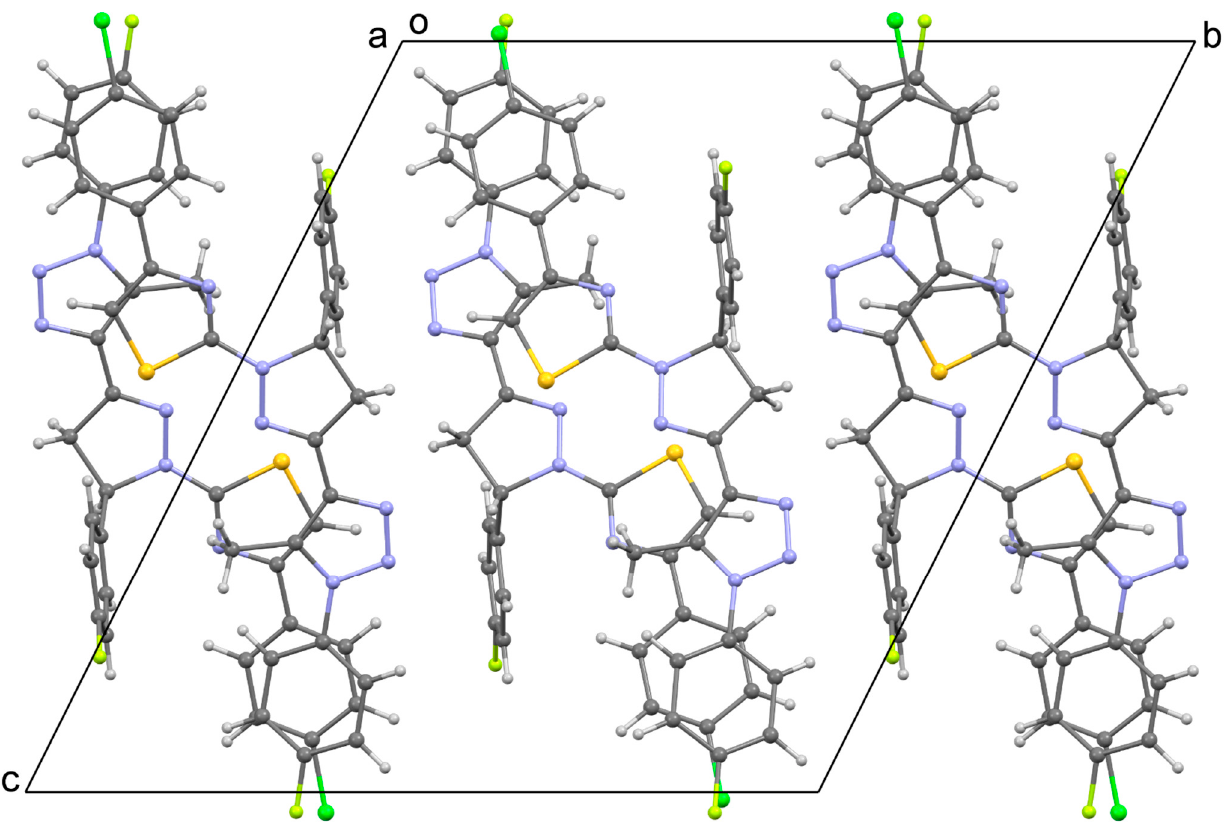
Figure 2. Ortep representation of the asymmetric unit showing 50% probability ellipsoids for ( a ): 4 and ( b ): 5 .